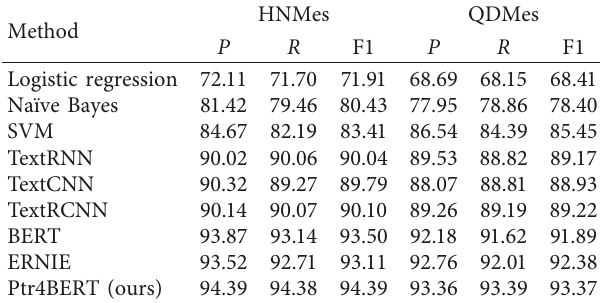
Table 2: Performance comparison of different